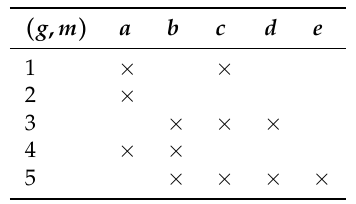
Table 3. A tabular form, or cross table, with U = { 1,2,3,4,5 } and A = { a , b , c , d , e } . The relation I is indicated by the set of crosses in the table.